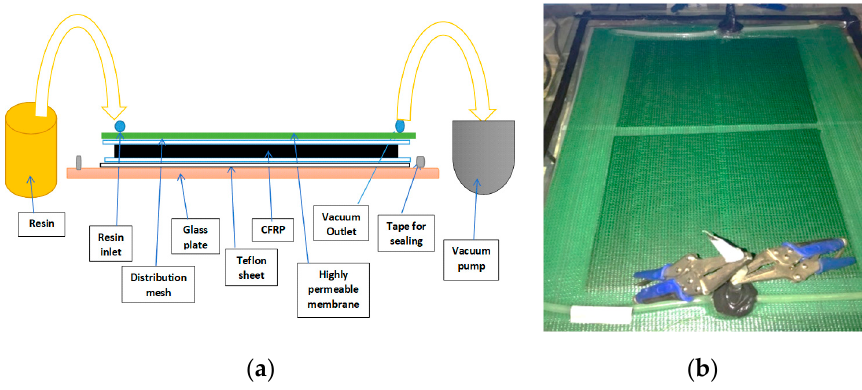
Figure 2. Illustration of vacuum-assisted resin infusion (VARI) molding process ( a ) Schematic and; ( b ) Photographic images.